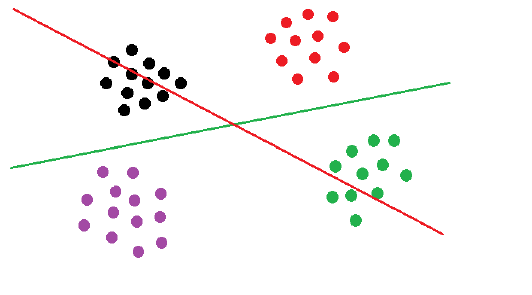
Figure 1. Red partition : highly balanced split but impure (the partition cuts through the black and green classes). Green partition : highly balanced and highly pure split. Figure should be read in